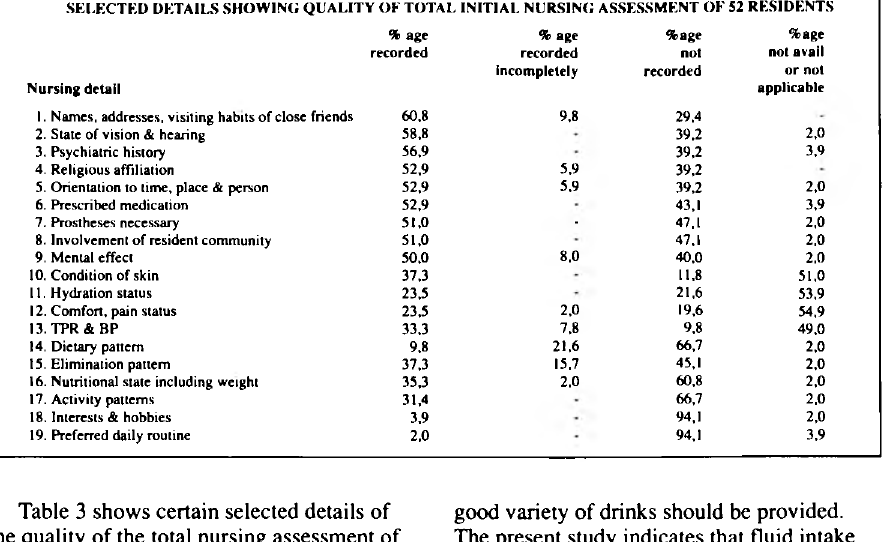
TABLE 3. SELECTED DETAILS SHOWING QUALITY OF TOTAL INITIAL NURSING ASSESSMENT OF 52